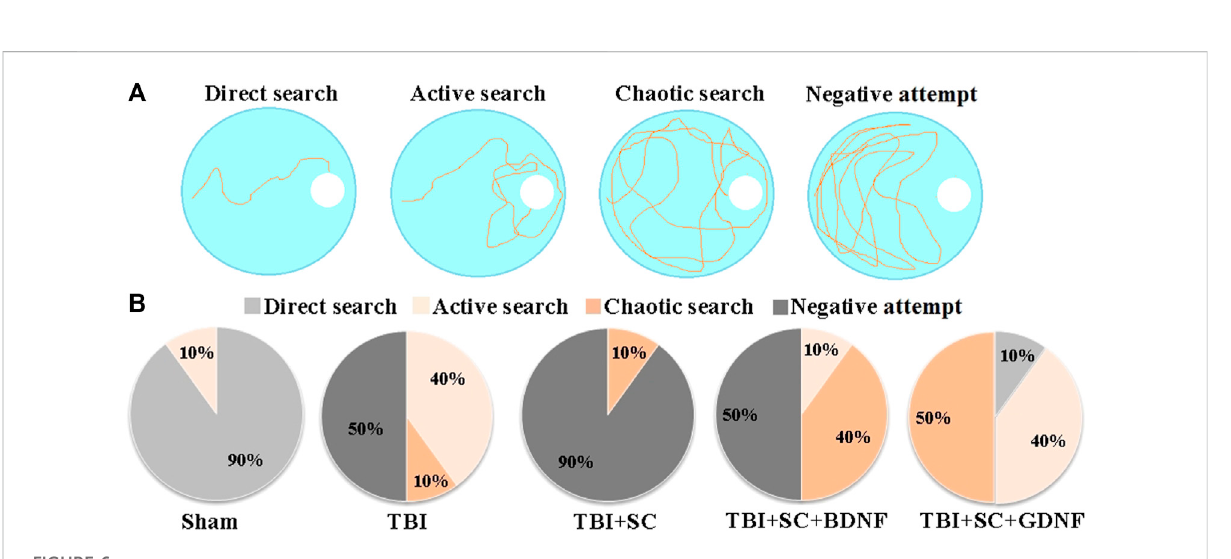
Frontiers in Bioengineering and